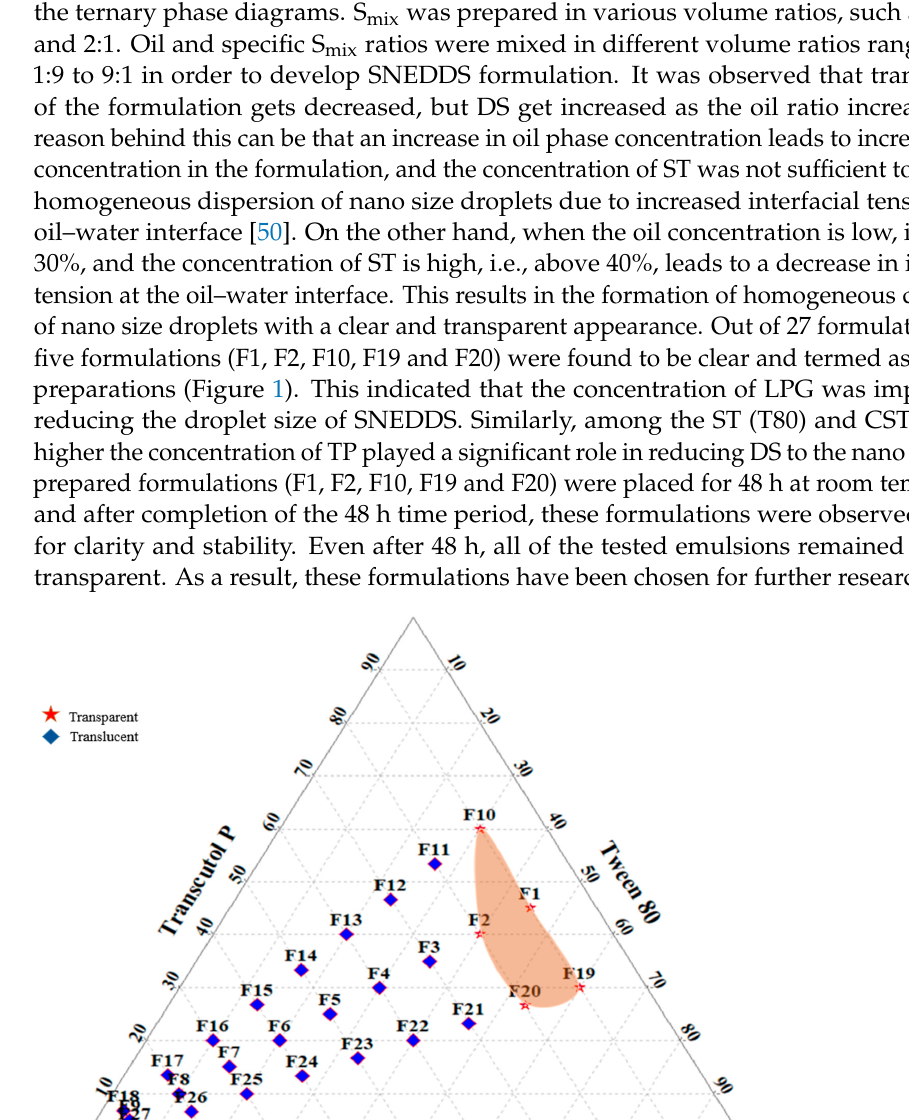
Table 2. Evaluation parameters (n = 5) and composition of selected batches of XH loaded L-SNEDDS (% w/w ) . 硬回车